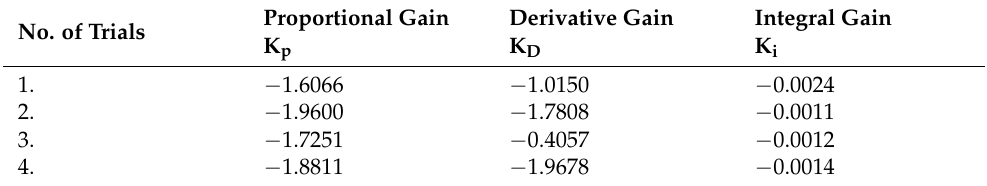
Table 5. Optimized GOA result for controller gains of network 1. [K A = 0.8180, K B = 0.1121 & K pp = 0.67].